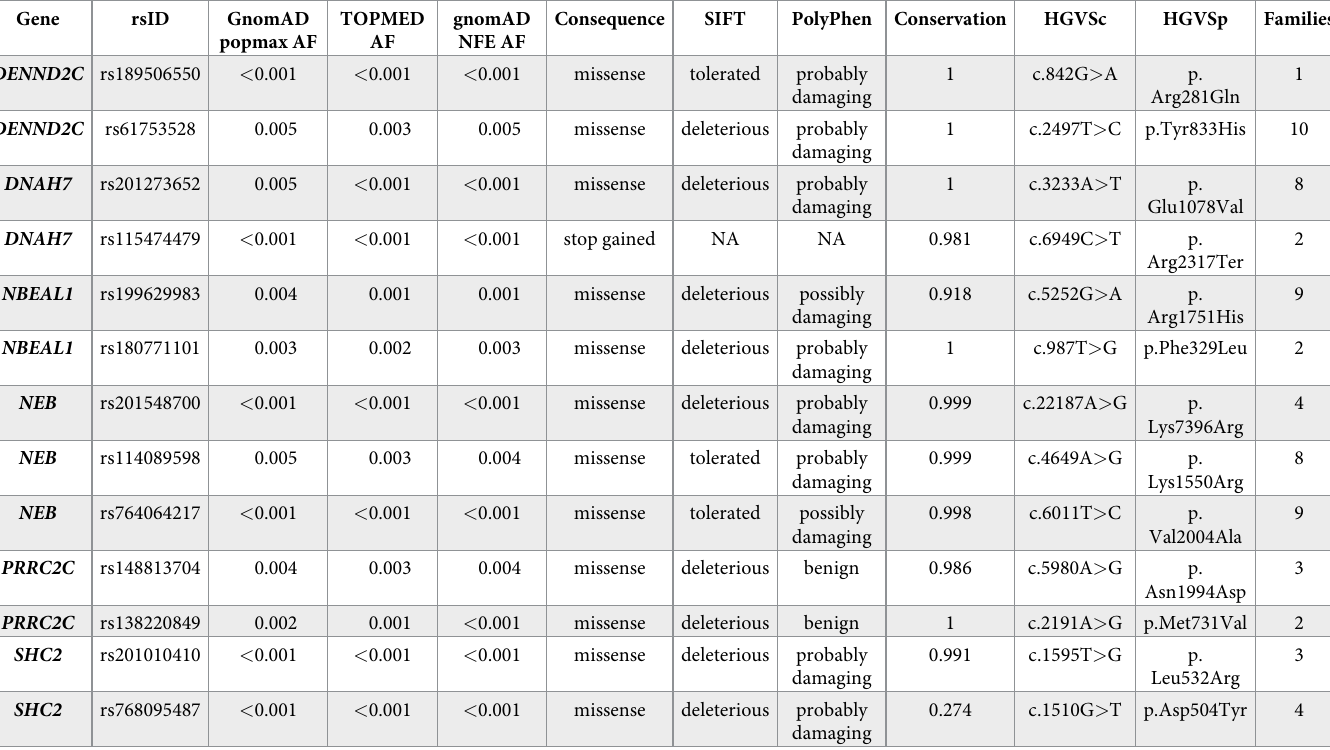
Table 2. A list of genes with co-segregating LOF variants in two or more families. NCBI reference SNPs (rsID) give previously described variants. GnomAD (pop- MAX/ non-Finnish European—NFE) and TOPMed allele frequencies were used to give the proportion of variants in the general population: 1 indicates presence across all individuals in the general population and 0 a complete absence. SIFT and PolyPhen were used on missense variants to predict the impact on protein functionality. Phast- Cons-7-way conservation scores were determined for SNVs: 1 indicates complete conservation across 7 mammalian species and 0 as no conservation. The families for which a particular variant is present are listed in the final column by the family